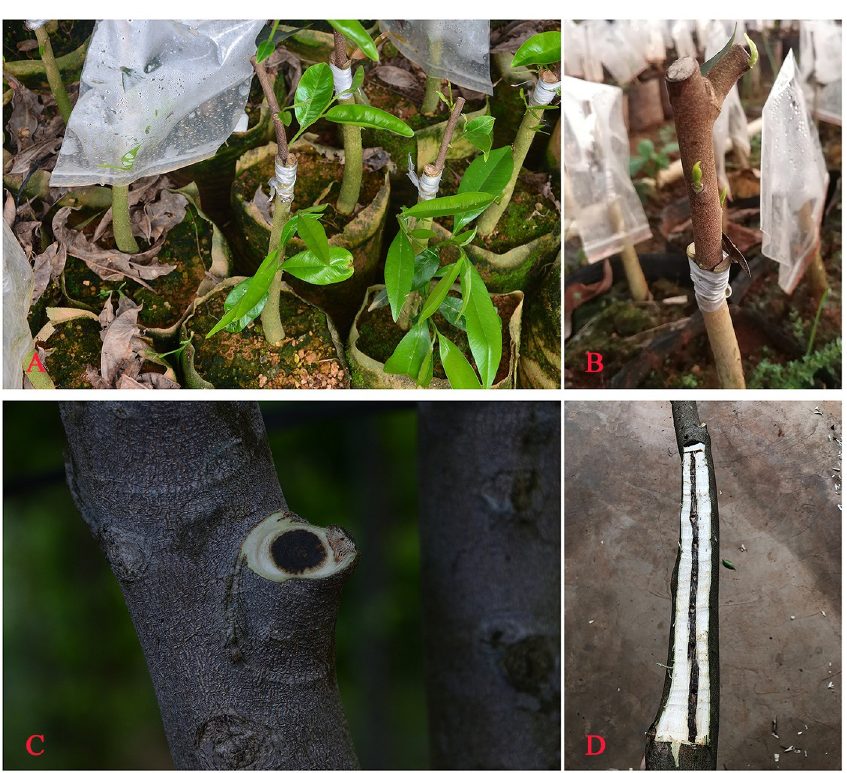
Fig 1. Grafting and agarwood formation with Qi-Nan germplasm. A and B: Grafting of Qi-Nan germplasm. C and D: Agarwood formation with Qi-Nan